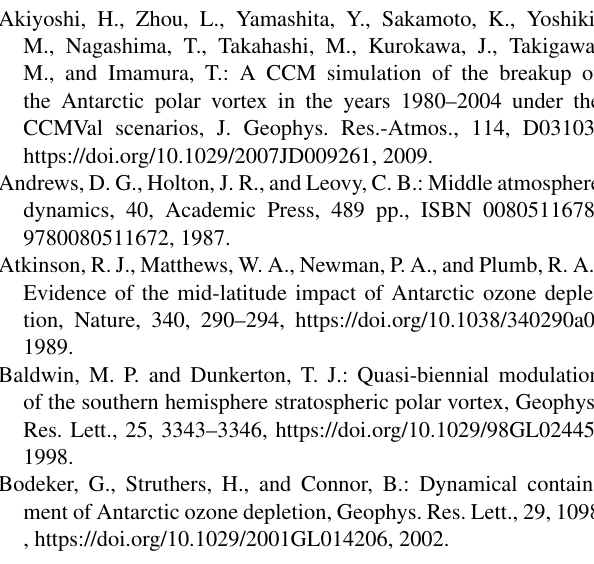
Average breakup day over the period and for the 3